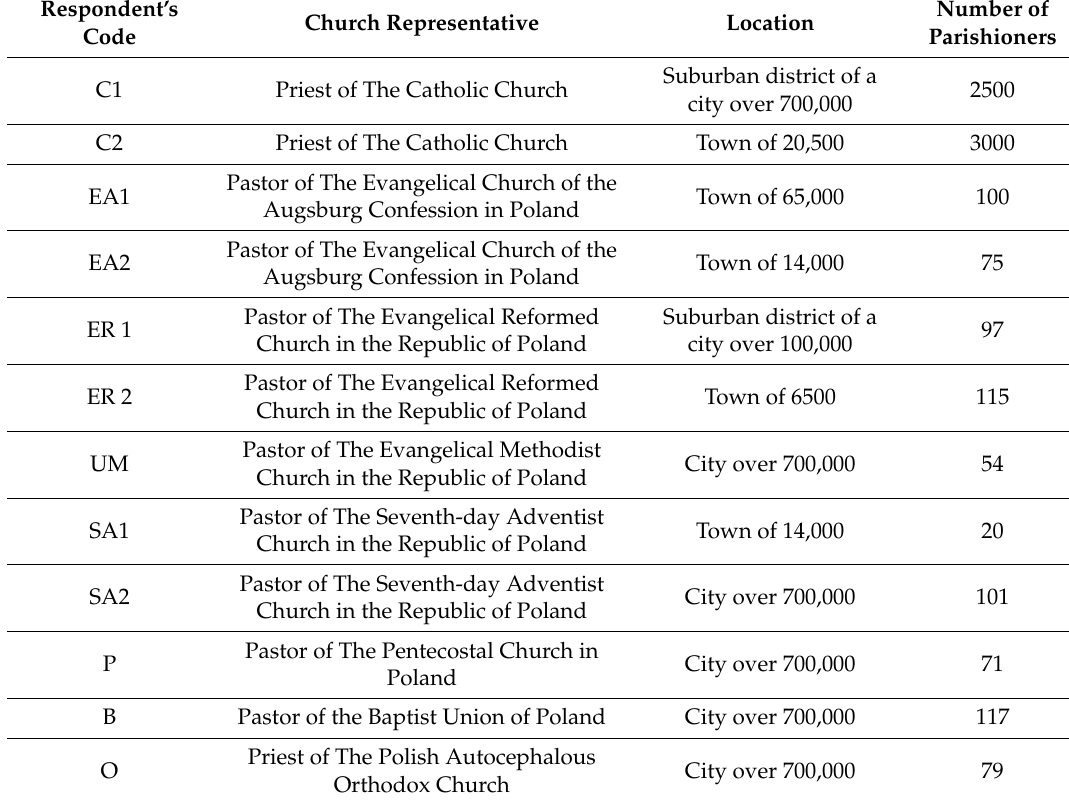
Table 1. Respondents codes participating in the